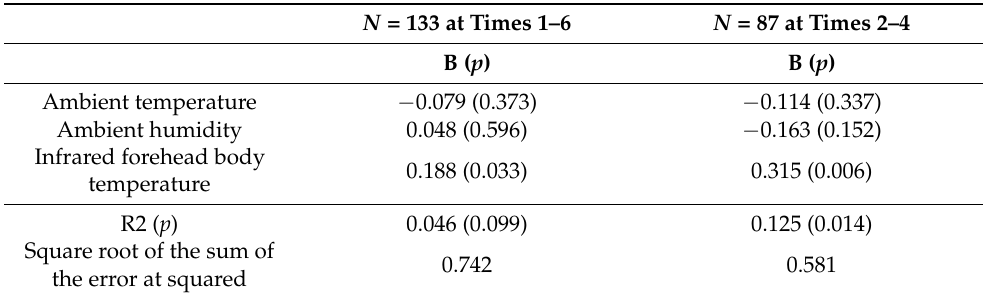
Table 3. Regression models with infrared forehead body temperature and ambient temperature and